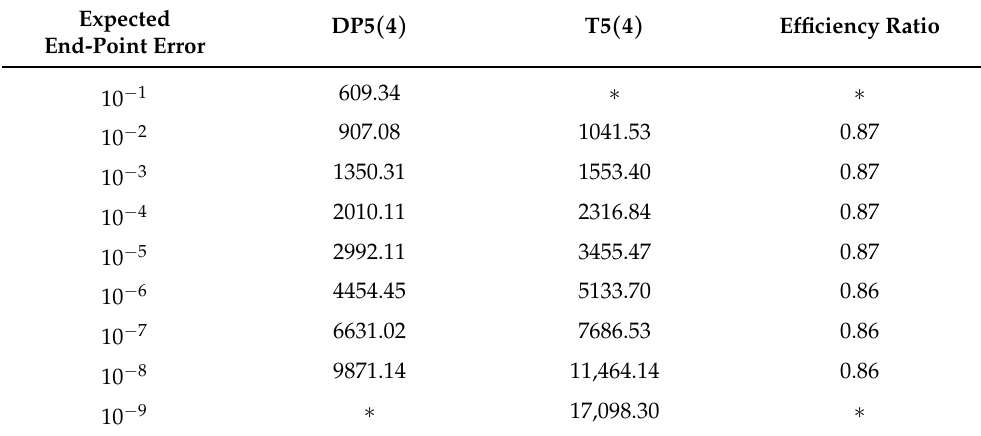
Table 3. Stages that might have been spent for achieving various errors by both pairs for Keplerian orbit with eccentricity γ = 0.6. Stars indicate unavailability of data to attain the perspective errors. Expected DP5 ( 4 End-Point Error